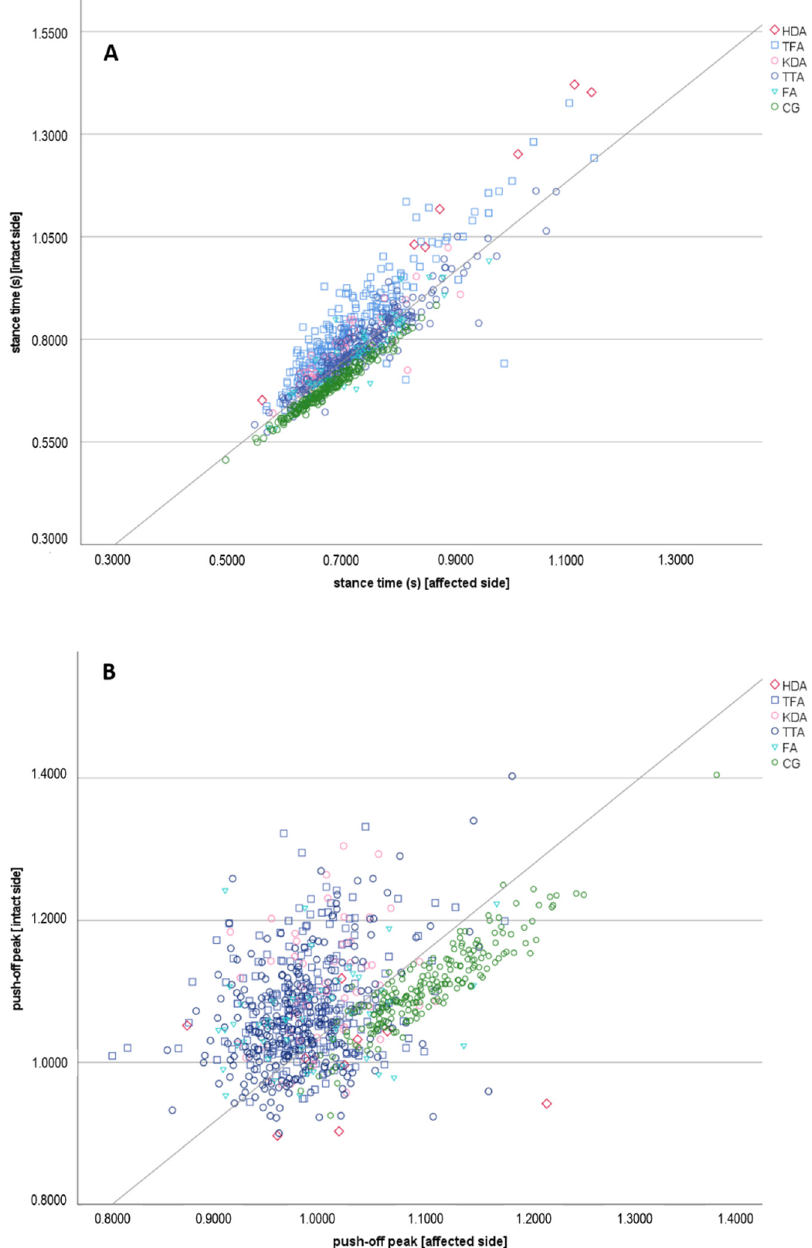
Figure 1. ( A ): Stance time difference between the intact and affected limb at different amputation levels and in healthy participants (left/right side, resp.) ( B ): Push-off peak difference between the intact and affected limb at different amputation levels and in healthy participants (left/right side, resp.).